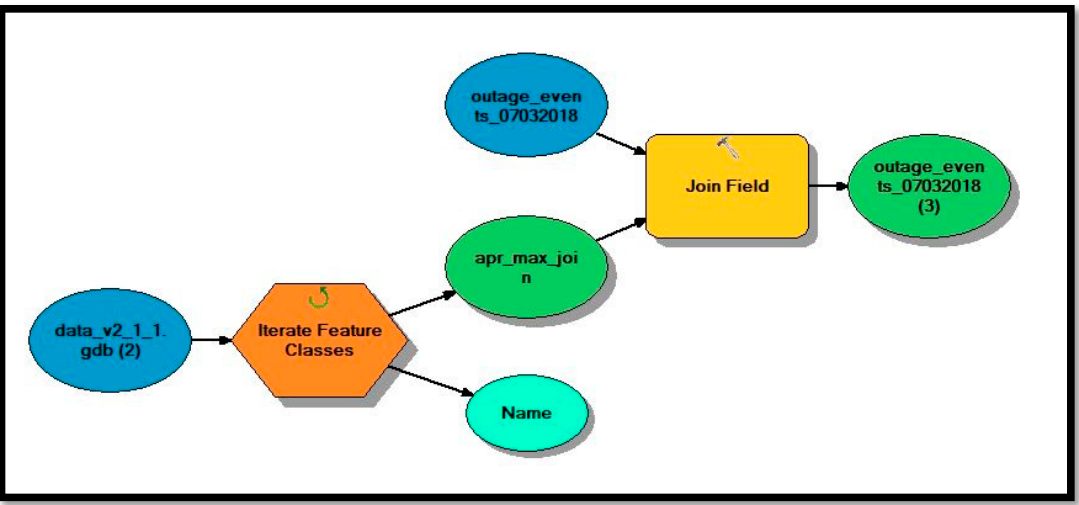
Figure 7. ArcMap ModelBuilder (Model 3) to join outage-events data with the 48 fields of weather data.